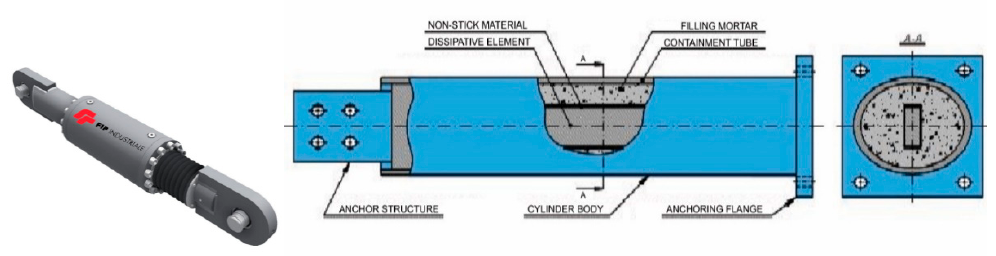
Figure 4. Buckling-restrained axial dampers (BRAD) 14/40-b dissipater inside the frame grid. Figure 5. Detail of a BRAD ® device.